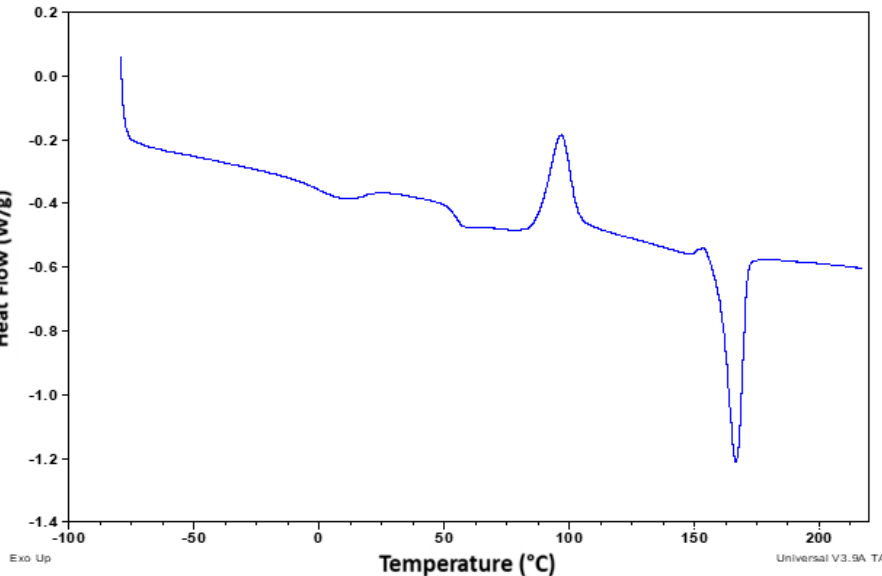
Figure 3. Typical DSC thermogram of a PLA/Hytrel blend (second thermal cycle with a heating rate of 10 ◦ C/min). Table 3. Glass transition ( T g ), melting ( T m ), and crystallization temperatures ( T c ), and the crystallinity percentage ( χ c ) of PLA/Hytrel blends determined from the second thermal cycle with a heating rate of 10 ◦ C/min. T m Hytrel ( ◦